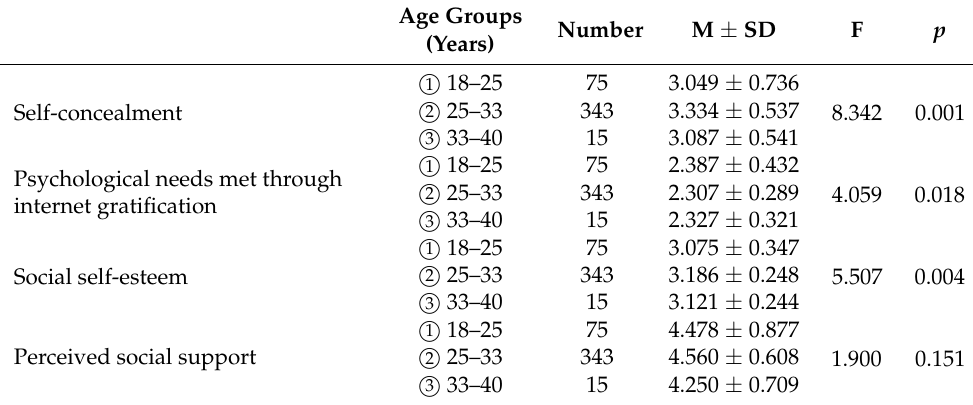
Table 2. Age group differences in all